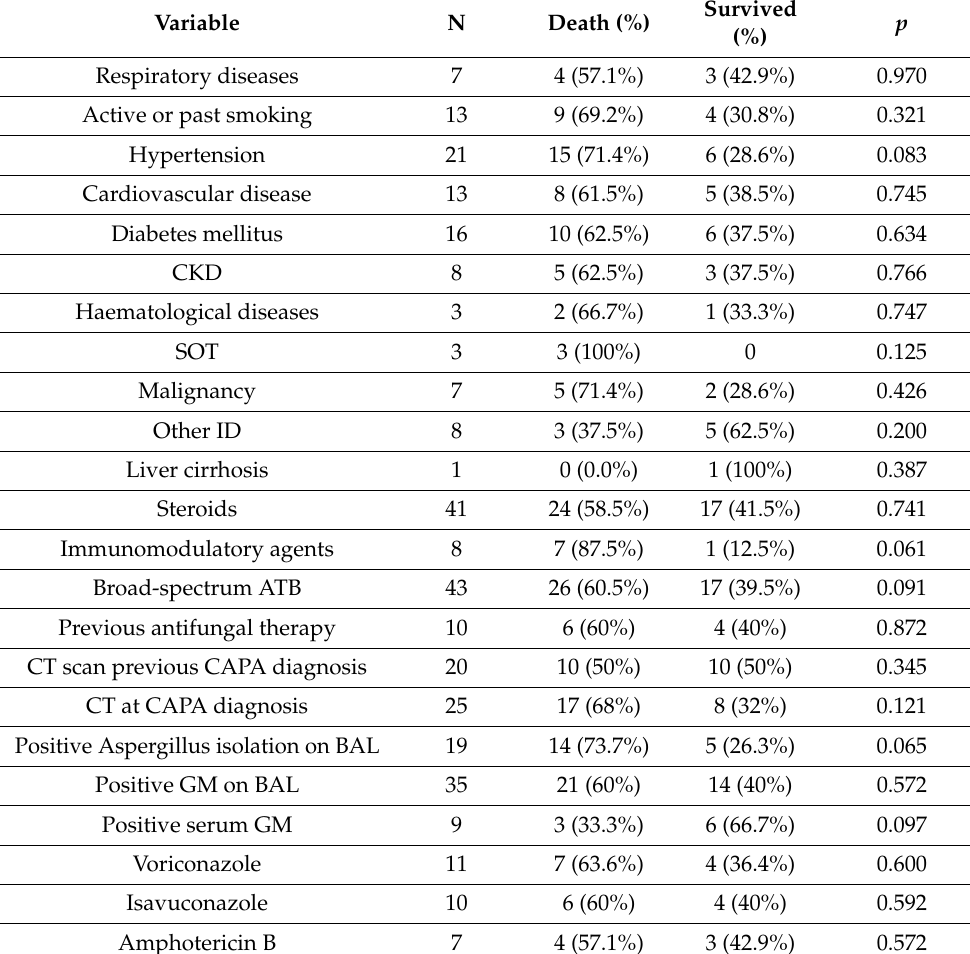
Table 5. Patients’ characteristics and risk factors for mortality at 28 days from the admission in ICU of CAPA